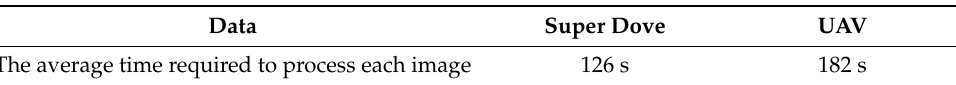
Table 4. Approximate time required to extract U. prolifera from Super Dove and UAV images. The time required is averaged over 16 Super Dove images with 14,175 × 10,404 pixels per image and 10 UAV images with ~18,000 × 9000 pixels per image.